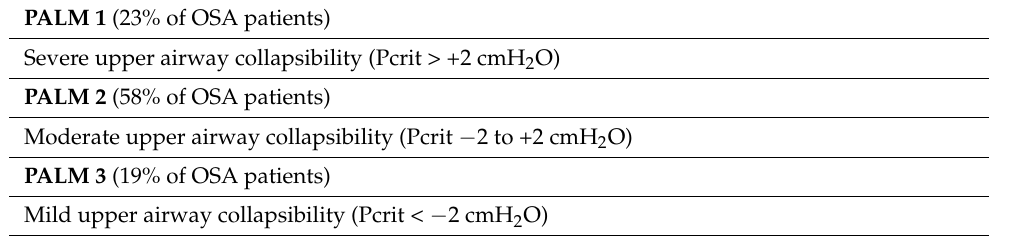
Table 2. PALM Scale. PALM 1 (23% of OSA